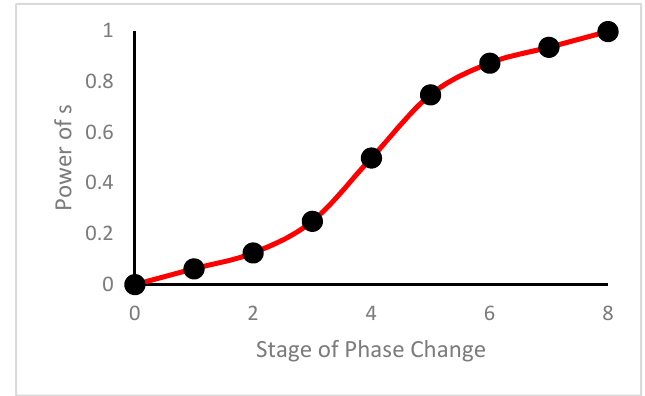
Figure 4. Power of s in fractal evolution.